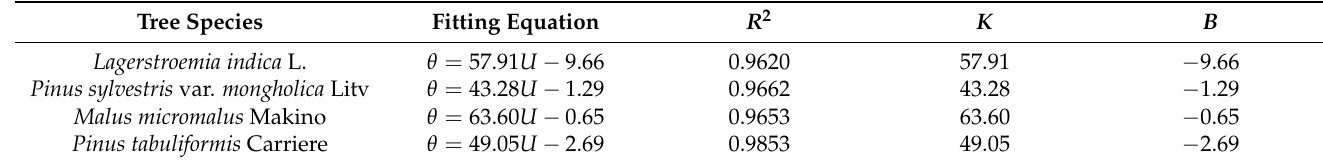
Table 3. Fitting equation of value of stem water content ( θ ) and U